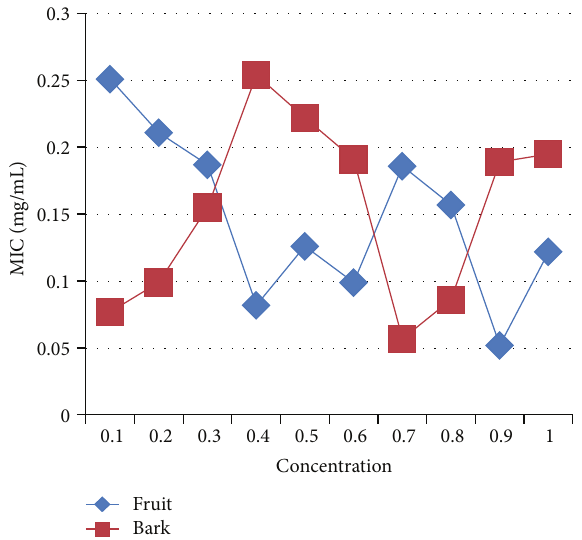
Figure9:MICvalues(mg/mL)exhibitingpotentialofbarkandfruit of C. ambrosioides against E. coli .